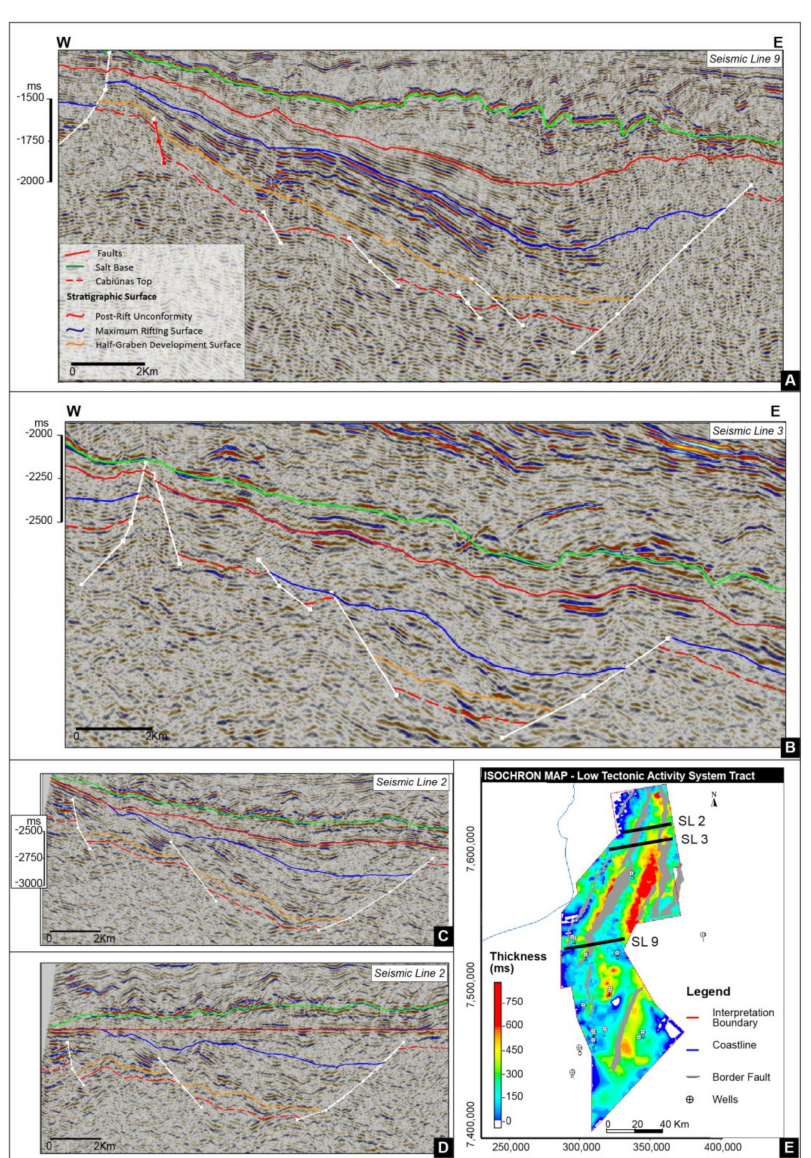
Figure 13. The Low Tectonic Activity Systems Tract (LTAST). ( A ) Seismic line 7 shows decreasing displacement of the border fault in the LTAST, dominated by seismic facies 2, with some occurrences of seismic facies 3. ( B ) Seismic line 3 shows the dominance of seismic facies 2, with localized concentrations of seismic facies 3 in LTAST (interval between blue and red surfaces). ( C ) Seismic line 2 shows the extremely erosive signature of the post-rift unconformity (red surface), not only at the flexural margin, but also across the half-graben. ( D ) Seismic line 2 shows flattening of the LTAST top (post-rift unconformity surface), highlighting the erosive truncation in red surface. ( E ) ‘Isochronpach’ map (thickness in seismic time) of the